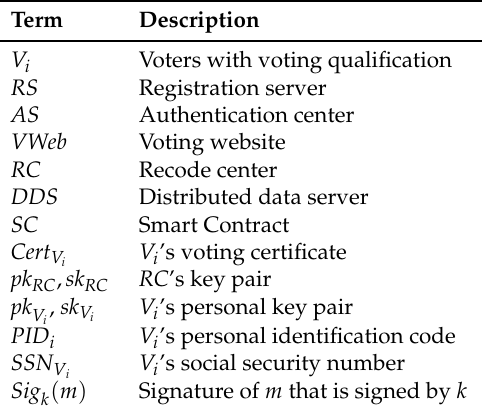
Table 1. Description of our E-voting